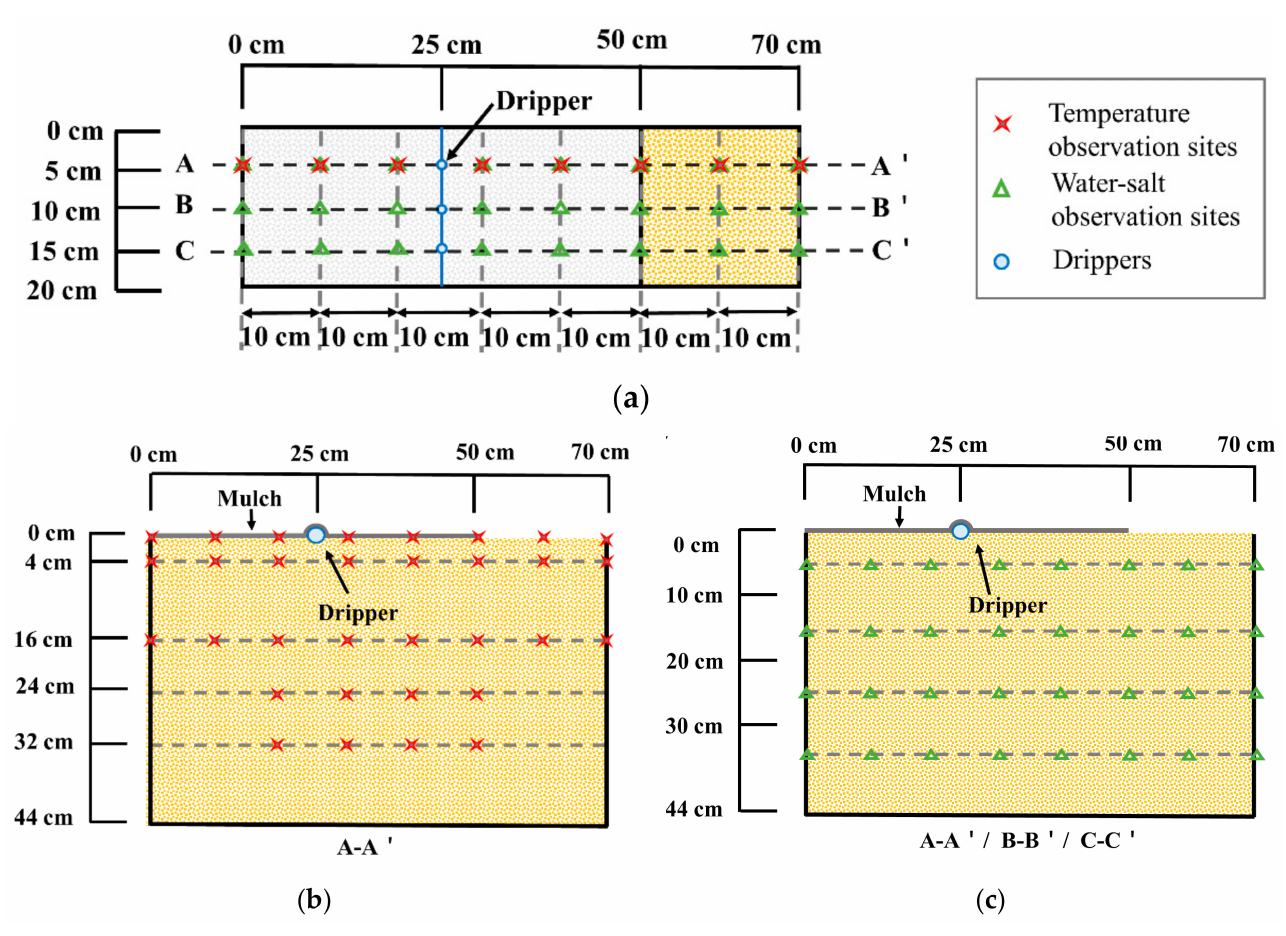
Figure 2. Locations of the observation sites: ( a ) Temperature monitoring and water-salt observation sites in horizontal plane view; ( b ) temperature monitoring points in vertical plane view; ( c ) water-salt observation sites in vertical plane